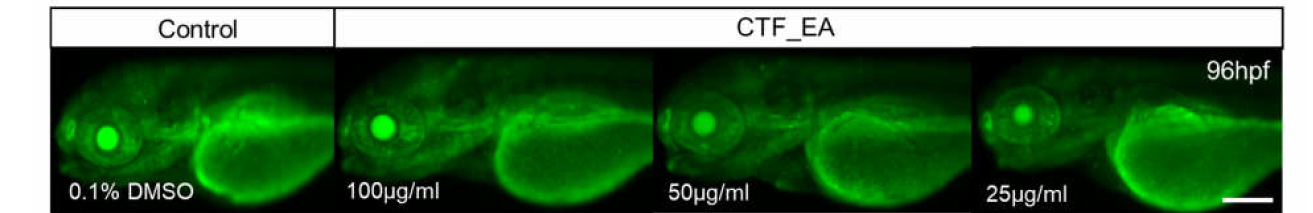
Figure 19. Visualization of apoptosis on CTF_EA-treated zebrafish larvae at different concentrations of 100 µ g/mL, 50 µ g/mL, and 25 µ g/mL, respectively, using the vital fluorescent acridine orange staining. Signals in yolk and lens are autofluorescence. Scale bar, 200 µ